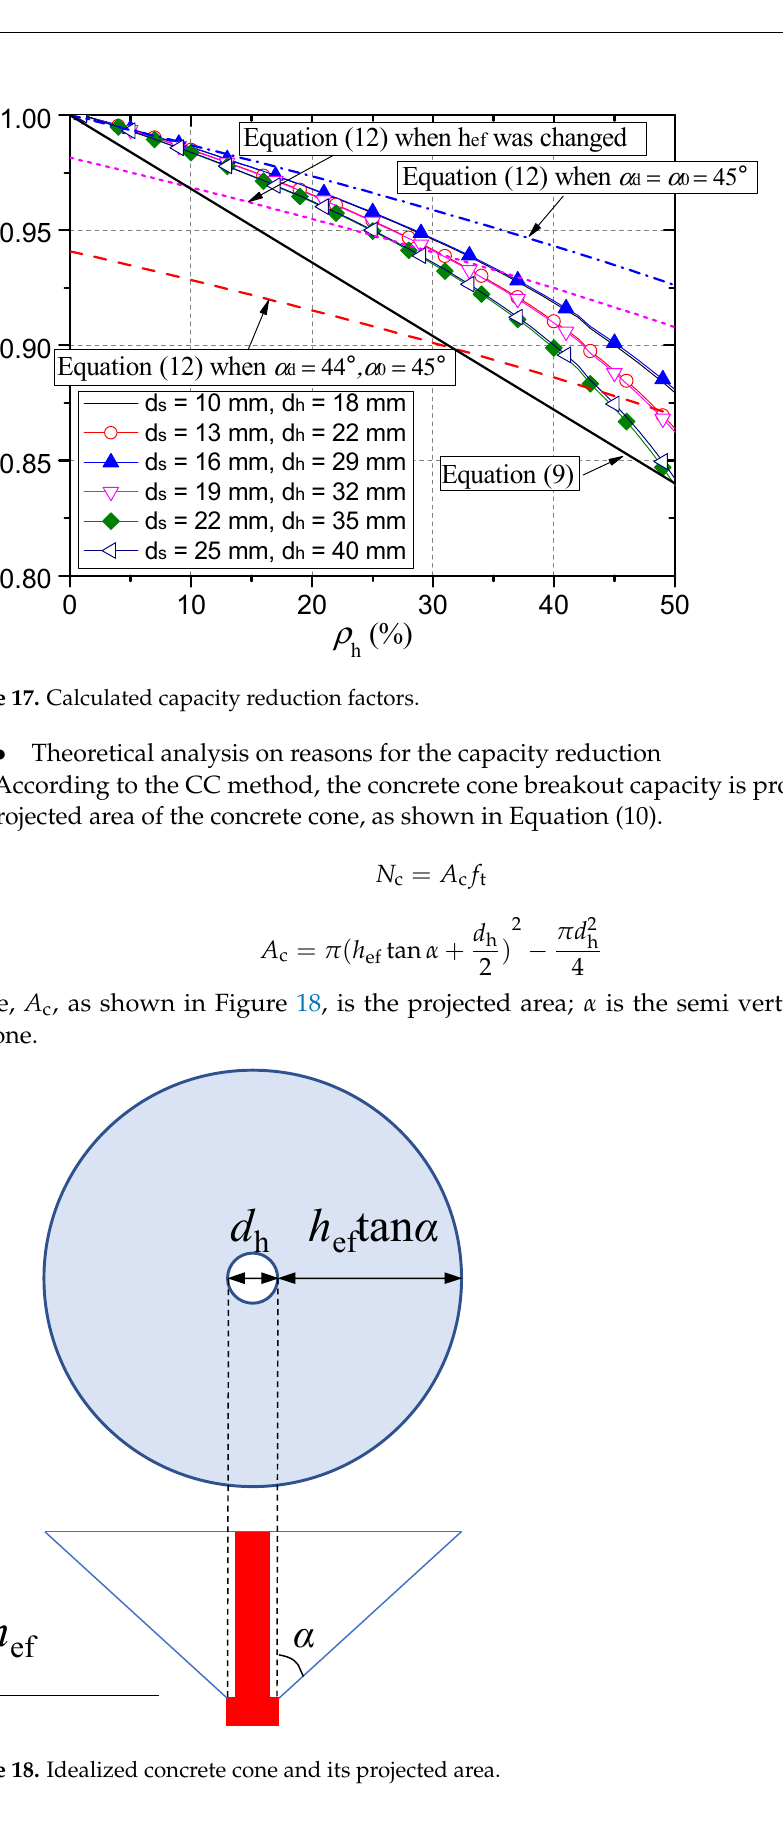
Figure 18. Idealized concrete cone and its projected area. The head-sectional damage affects the shape of the concrete cone and reduces its pro- jected area. When the damage degree is ρ h , the diameter of the stud head is ( ) h h 1- d ρ ⋅ , and the reduction factor calculated according to CC method is as follows. 2